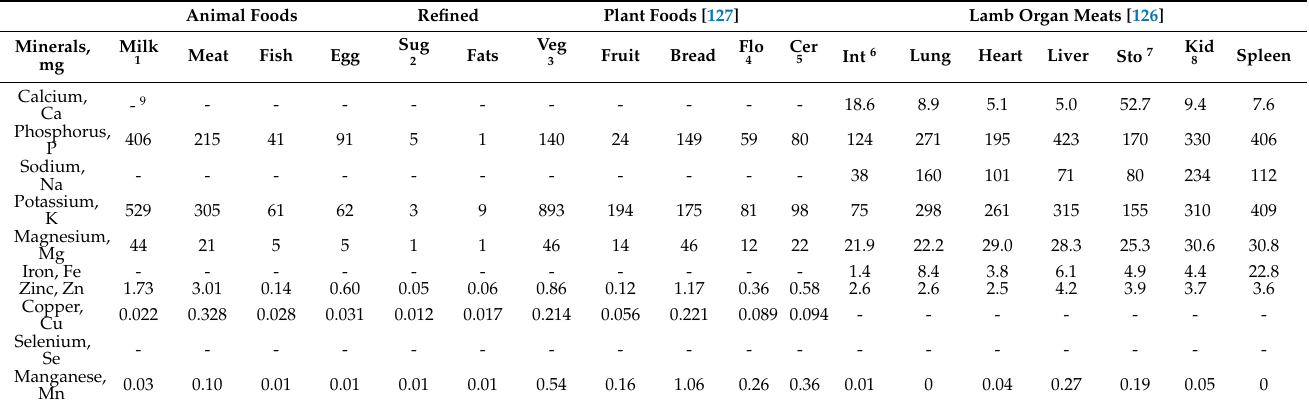
Table 2. Contributions by different groups of foods to intake of selected minerals in 1986 British households (mg per person per day) [127], as compared to mineral content of selected organ meats (lamb, per 100 g cooked edible portion)